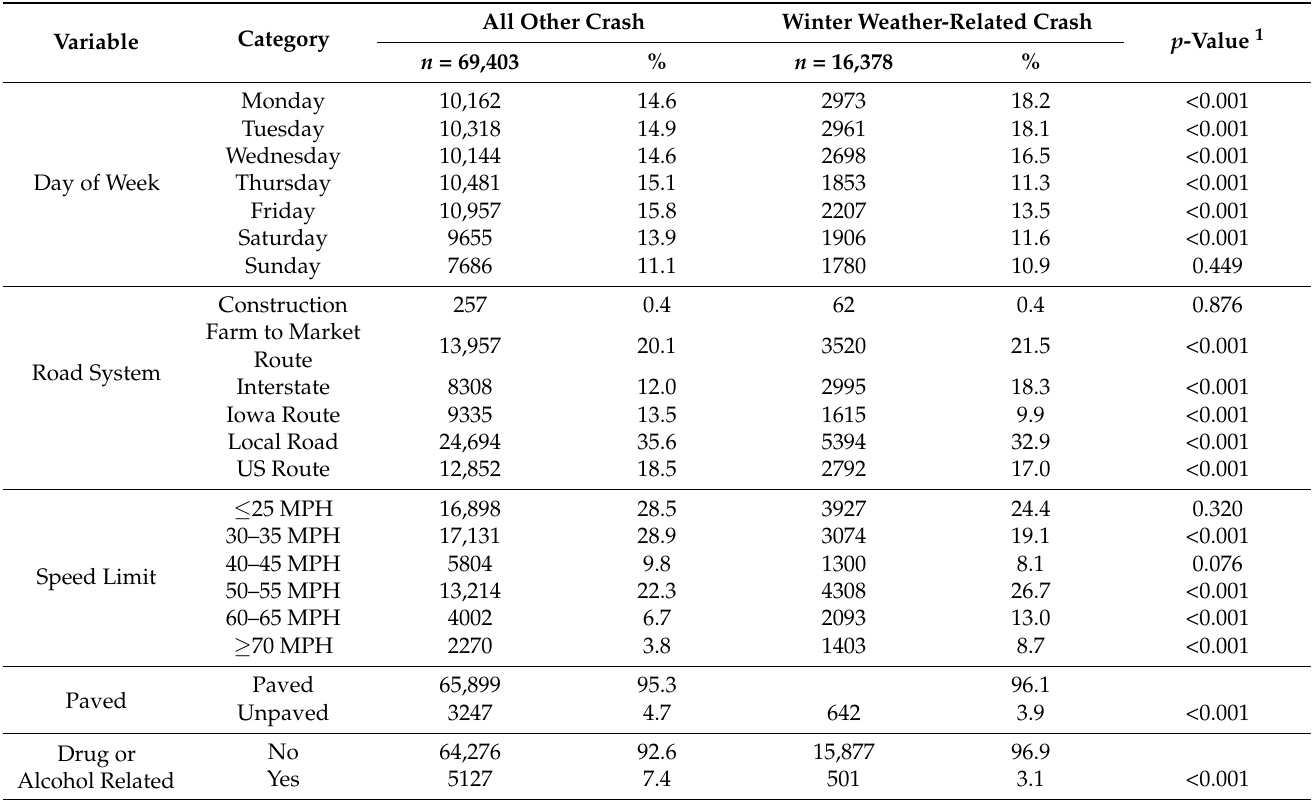
Table 1. Crash characteristics for crashes with and without a winter weather-related